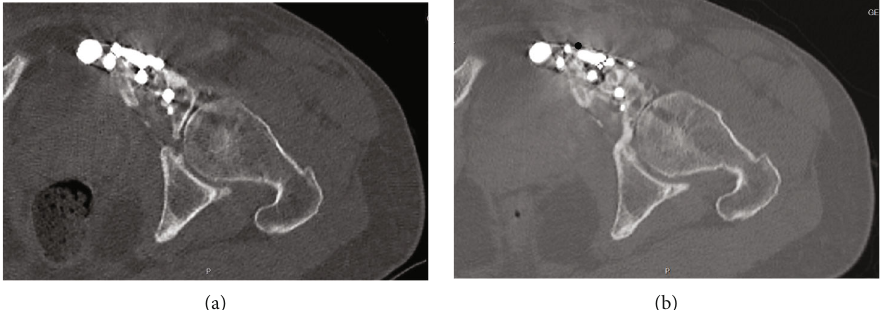
Figure 14: Axial view of a CT scan at 6 months (a) and at 30 months of follow-up (b) showing the healing of the osteotomy and the progression of osteoarthritis in the articular portion of the recycled